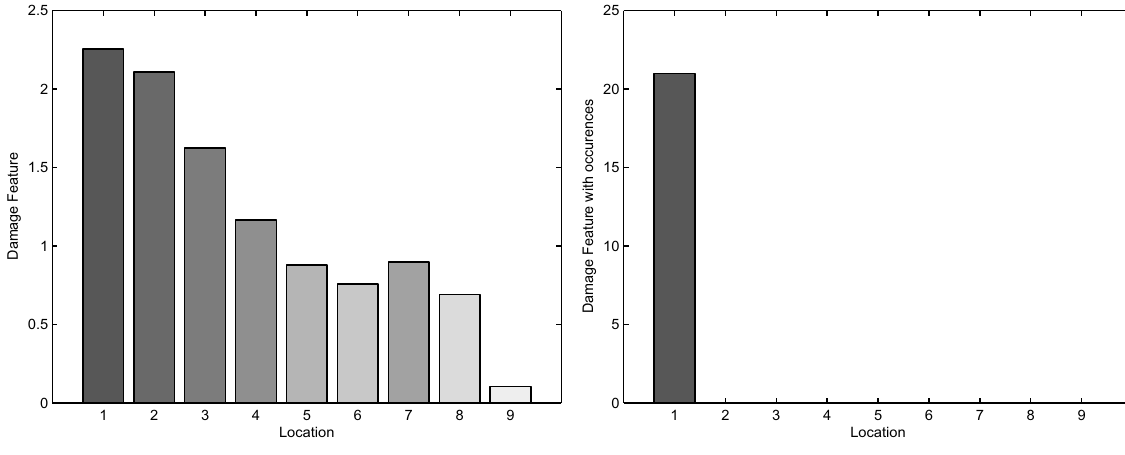
Fig. 25. Damage feature without and with occurrences for damaged structure and changing loading conditions, frequency range